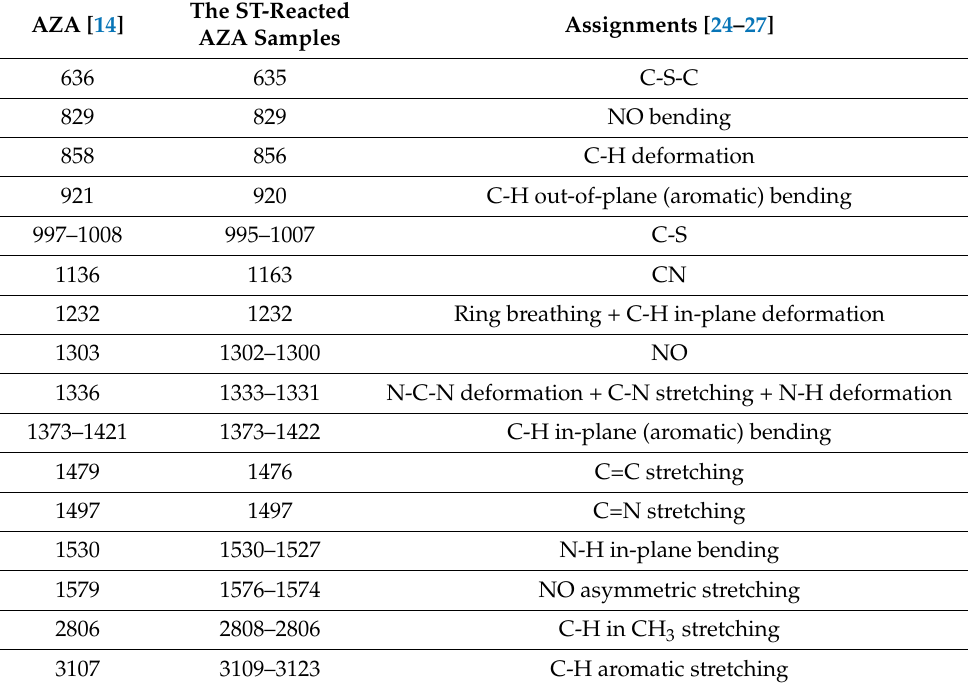
Table 1. Vibrational modes observed by IR spectroscopy in the AZA and AZA:ST samples, character- ized by ST concentrations in the reaction mixture of 25 wt.%, 50 wt.% and 75 wt.% (cm − 1